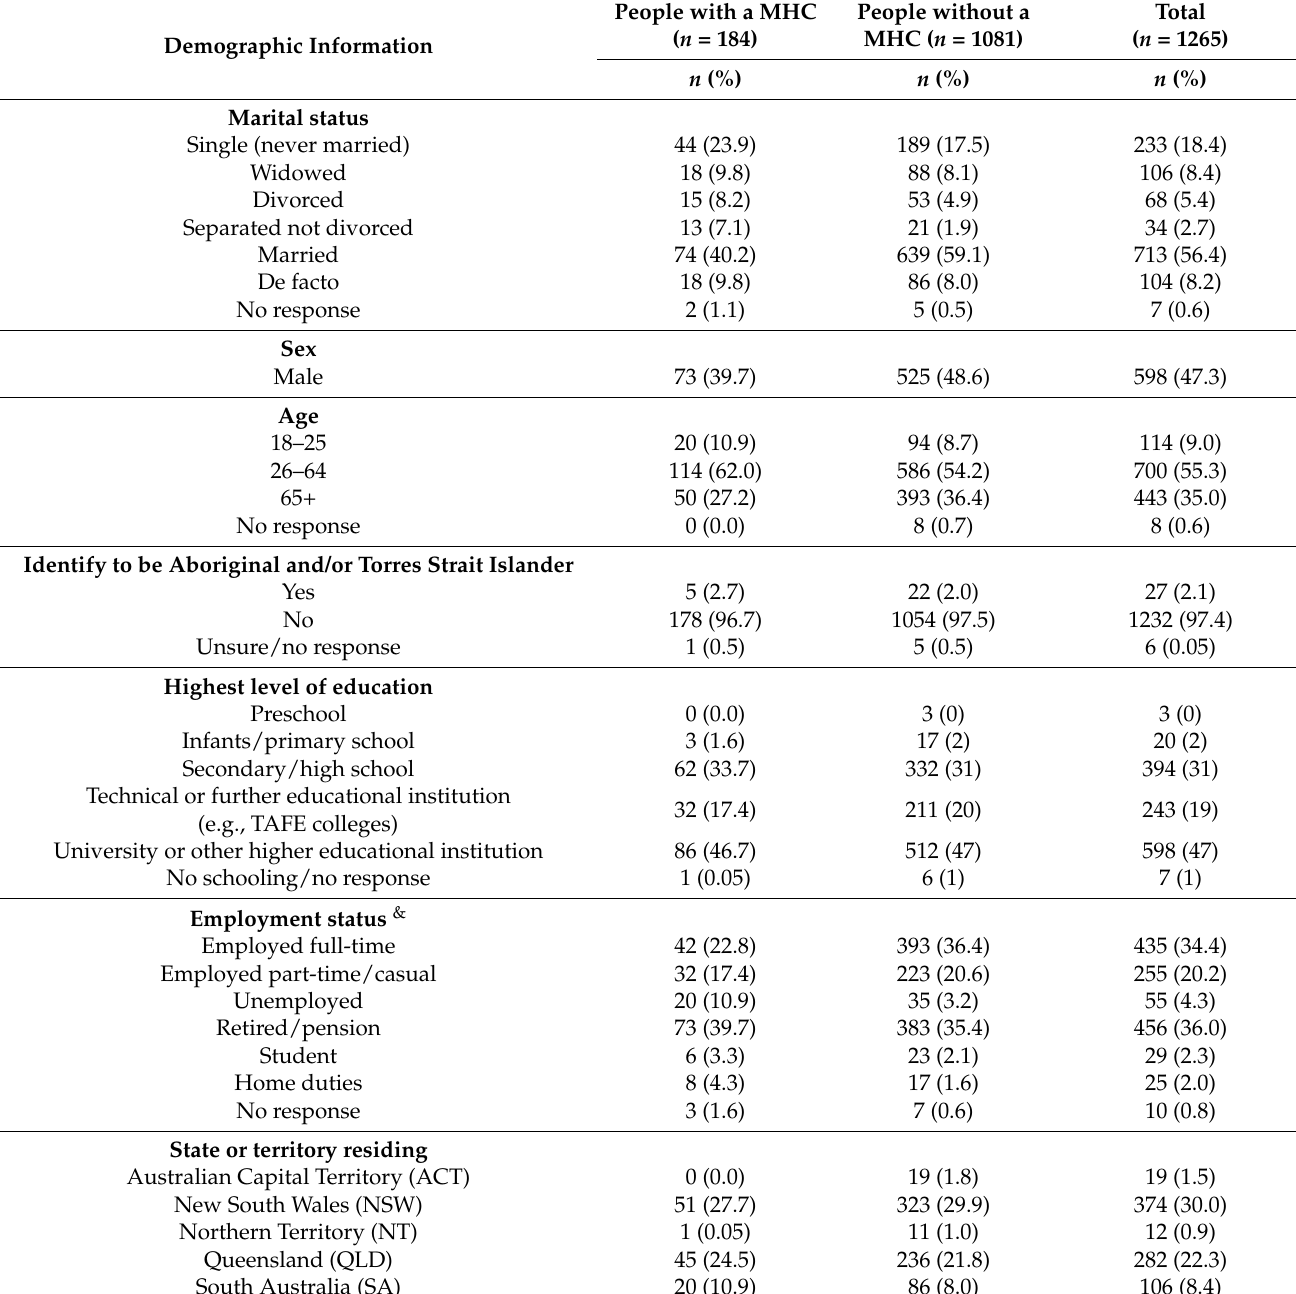
Table 1. Demographic Information and Health Status for Participants with and without a Mental Health Condition.